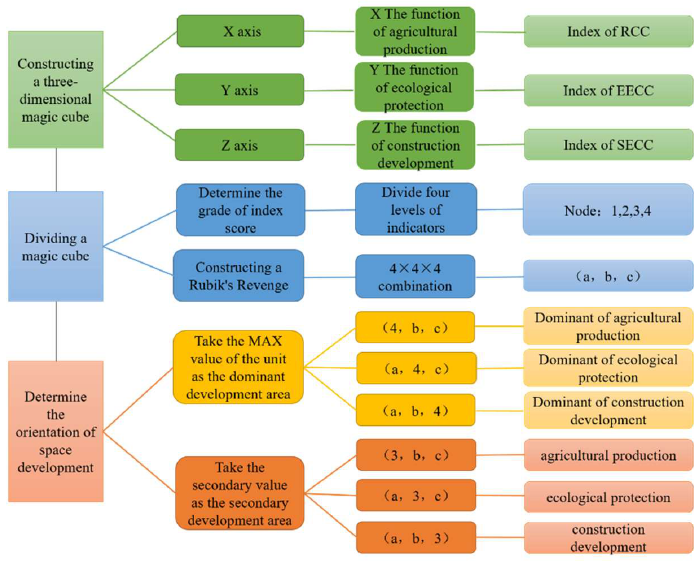
Figure 4. Three-dimensional magic cube space construction principle.